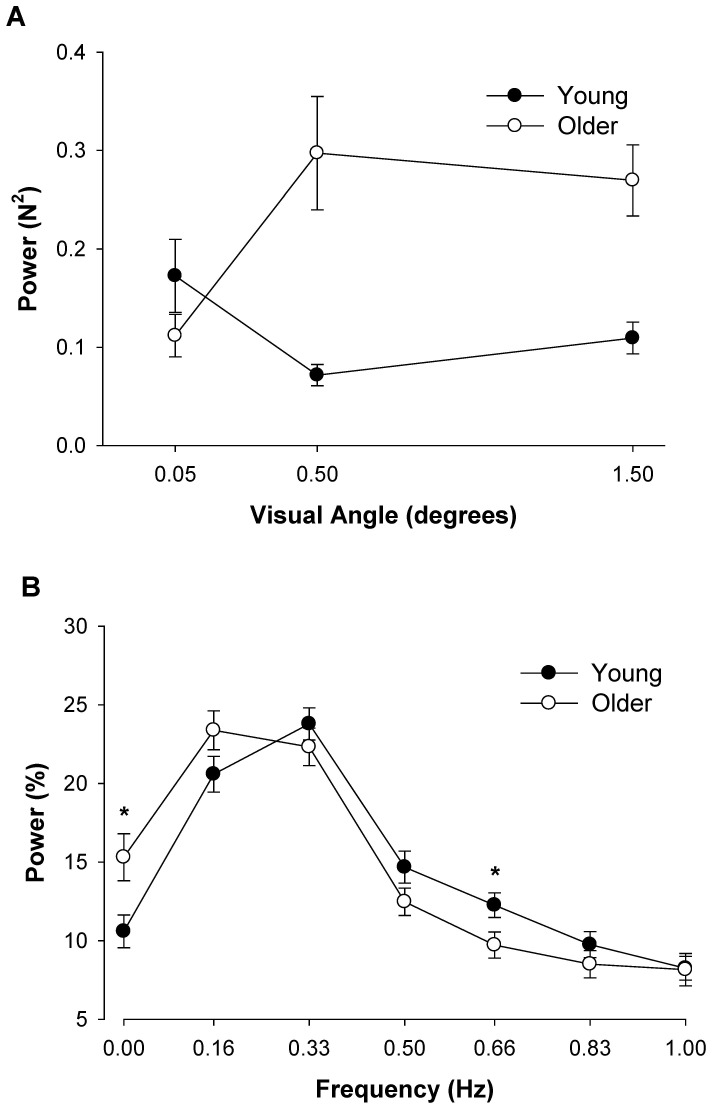
The interaction of age and frequency bins below 1 Hz.A: The absolute power during the three different visual angles. The age×visual angle approached significance (P = 0.06) and suggests that power within 0–1 Hz was greater in older adults for the visual angles that magnified the visual feedback. B: The normalized power for young and older adults at different frequency bins. On average, compared with young adults, older adults exhibited greater normalized power from 0–0.16 Hz and lower normalized power from 0.5–0.83 Hz. Post hoc analysis, indicates that these differences were statistically significant (P<0.05) between young and older adults at 0 Hz and 0.66 Hz. Asterisk (*) indicates significant difference (P<0.05) between young and older adults.